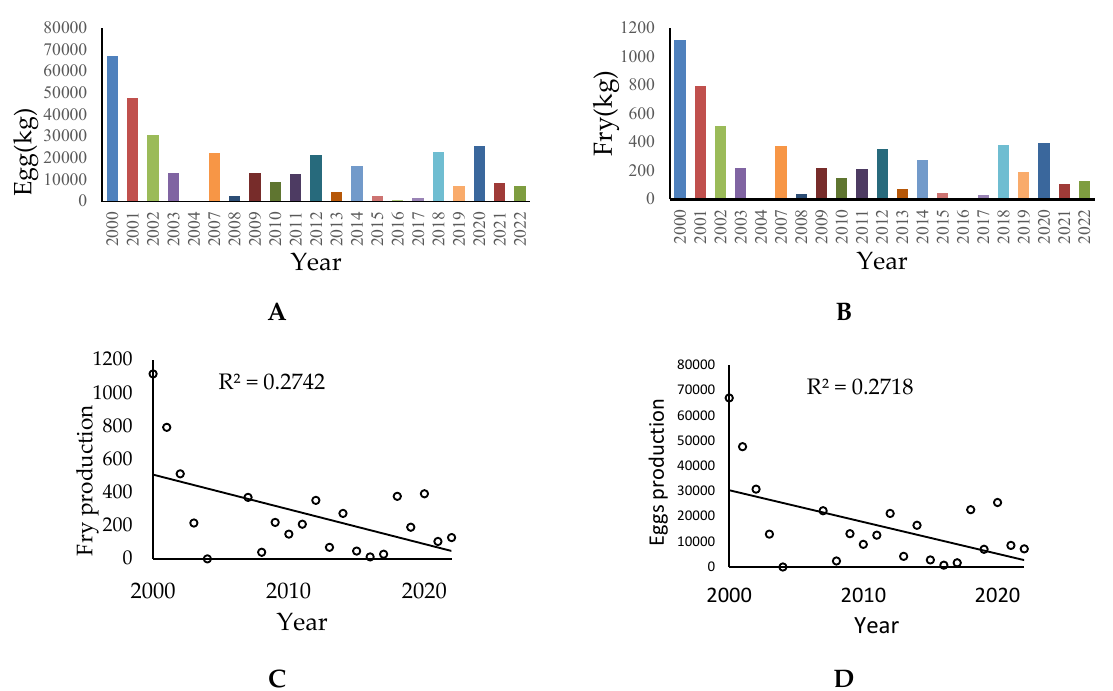
Figure 8. Status of carp fertilized egg and fry production over the last 22 years in the Halda River ( A , B ), and correlation between time series and eggs and fry production ( C , D ).